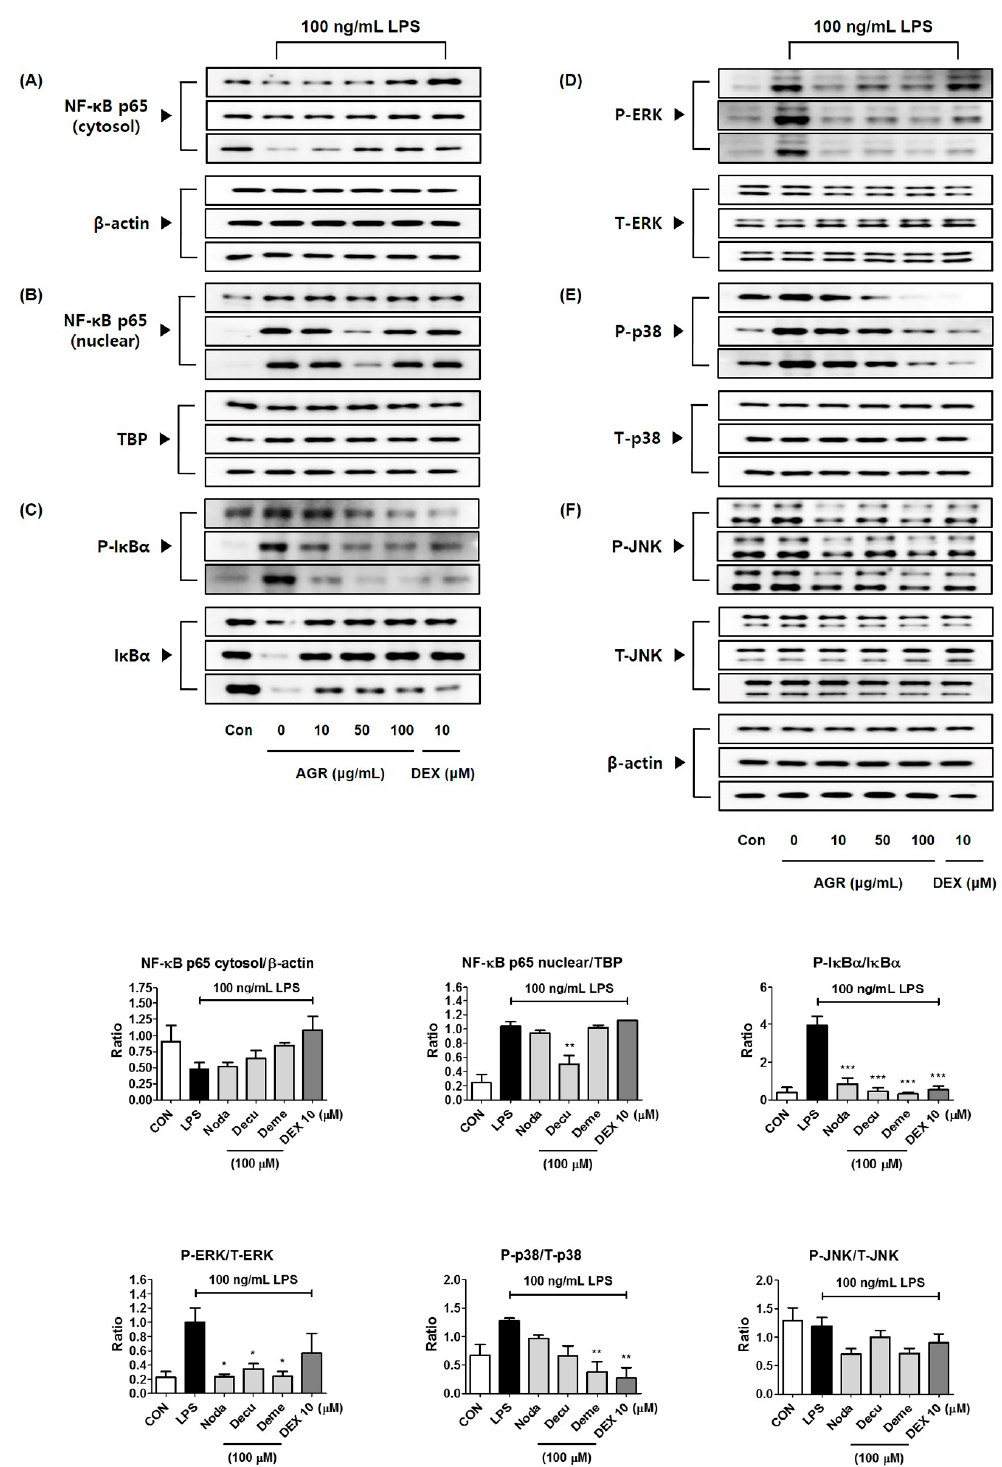
Figure 7. Effects of three compounds, nodakenin, decursin, and demethylsuberosin, on ( A , B ) nuclear translocation of NF- κ B p65, ( C ) phosphorylation and degradation of I κ B α , and phosphorylation of ( D ) ERK, ( E ) p38, and ( F ) JNK MAPK. Cells were stimulated with LPS for ( A , B ) 1 h or ( C – F ) 30 min. The histograms show protein expression levels relative to those of β -actin, TBP, or total-type protein. Data represent the mean ± SEM of three independent experiments. * p < 0.05, ** p < 0.001, and *** p < 0.0001 were calculated from comparisons with LPS stimulation